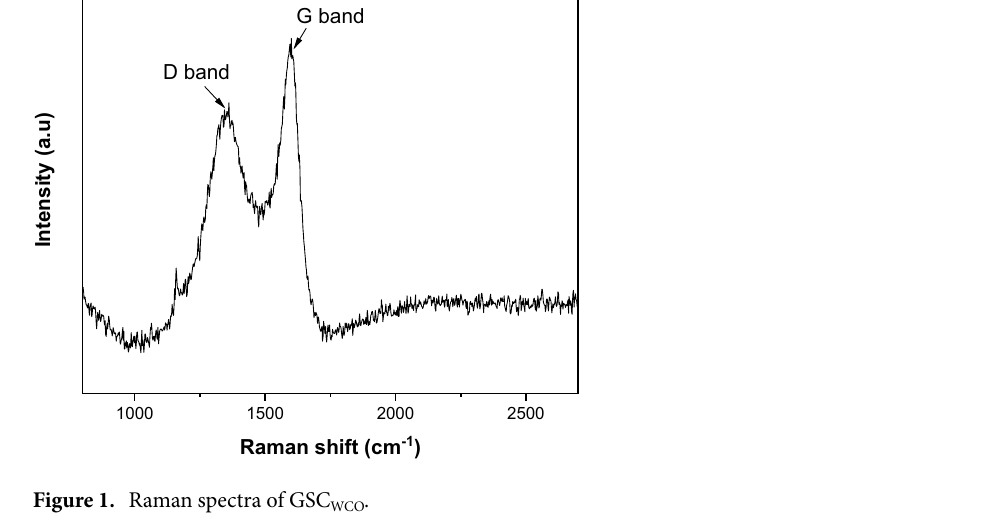
Figure 1. Raman spectra of GSC WCO